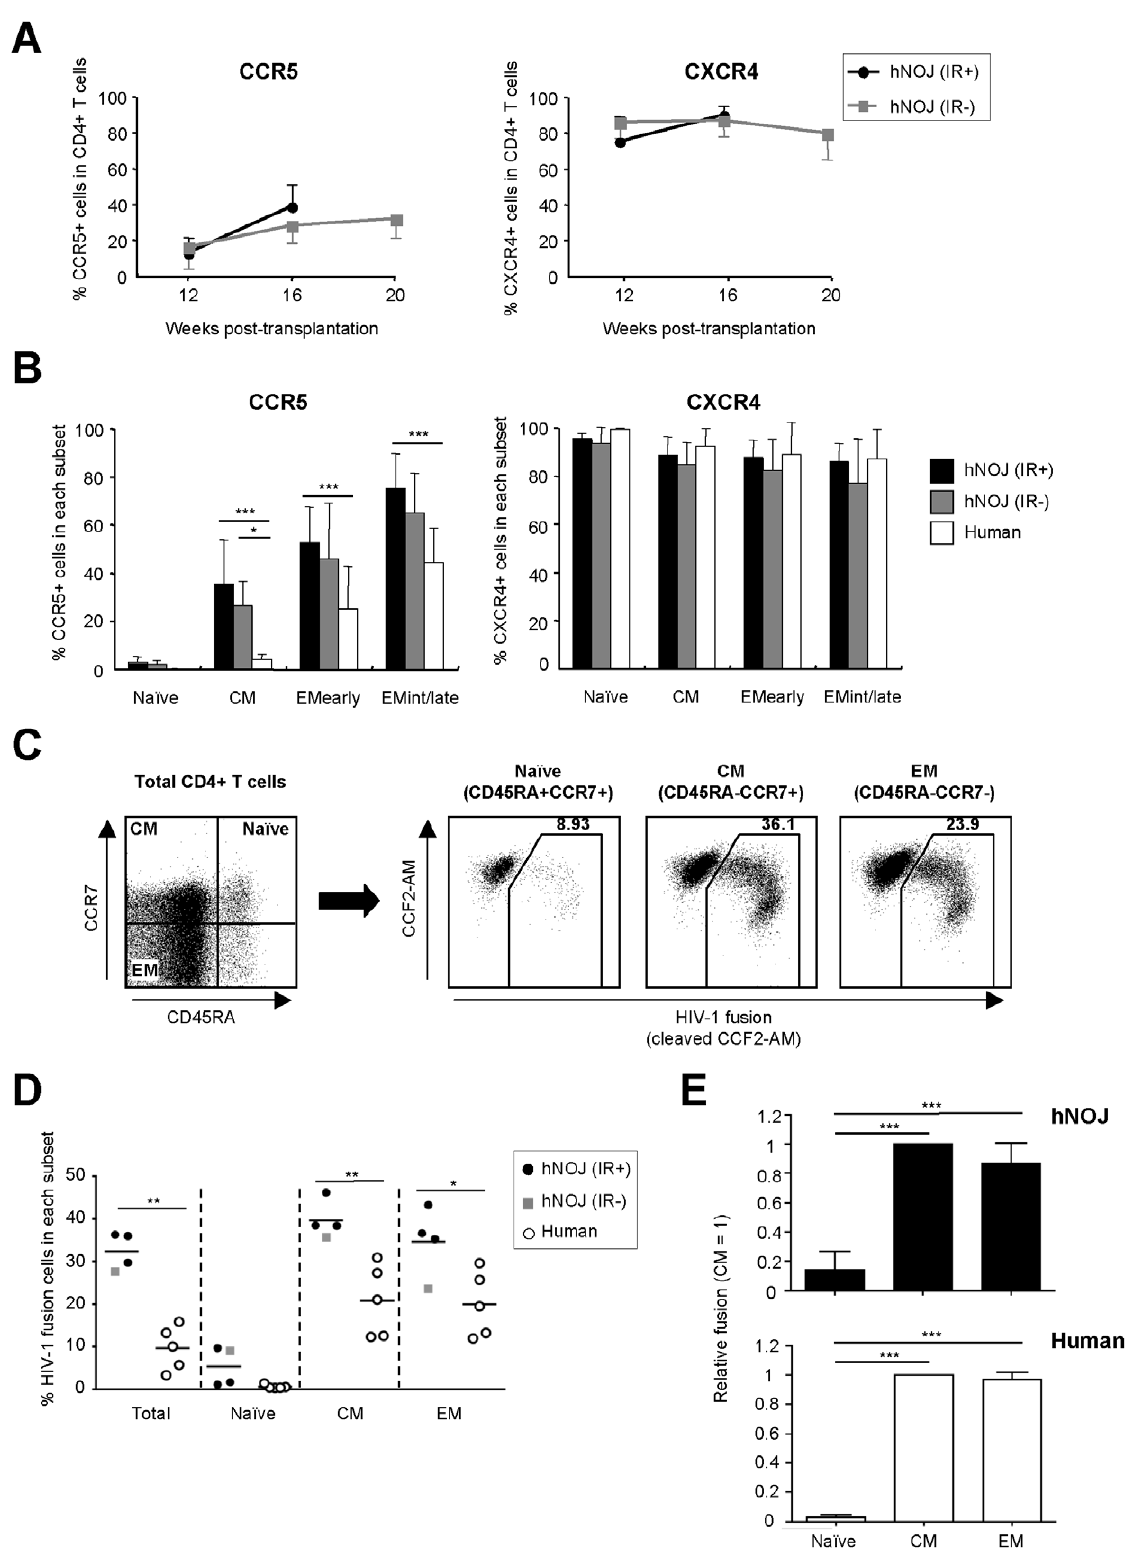
Figure 6. HIV-1 co-receptors, CCR5 and CXCR4, expression profiles and exvivo R5 HIV-1 infectivity of CD4 + T Cells in hNOJ mice. (A) Changes in the percentage of CCR5 + (left) and CXCR4 + (right) cells within the peripheral blood CD4 + T cell population isolated from hNOJ (IR + ) and hNOJ (IR 2 ) mice ( n =18 and n =6, respectively). Data are expressed as the mean 6 SD. (B) Percentage of CCR5 + and CXCR4 + cells within the naı¨ve, CM, EM early , and EM int/late subsets of peripheral blood CD4 + T cells isolated from hNOJ mice at 16 wk post-transplantation ( n =18 and n =6, respectively) and from humans ( n =5). Data are expressed as the mean 6 SD. Significant differences ( * P , 0.05, *** P , 0.001) were determined by two-